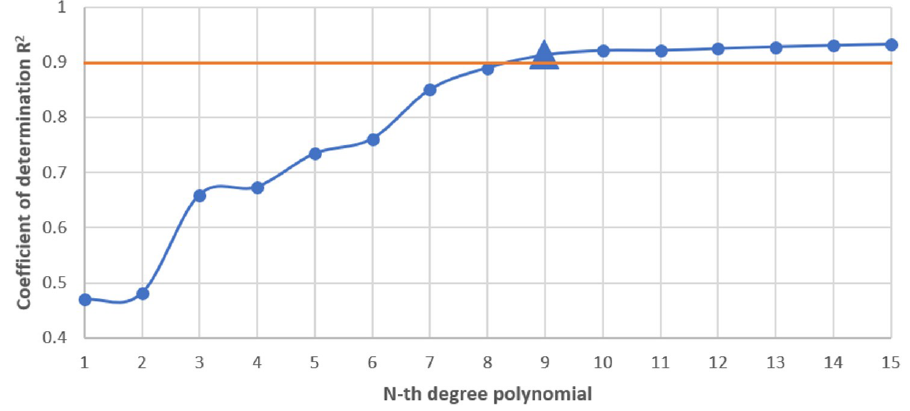
Figure 5. Coefficient of determination for subsequent polynomial functions of n-th degree. The 9th degree polynomial fitted curve has reached a coefficient of determination value of R 2 = 0.91. Figure 6 presents the curve fitted to the dataset.